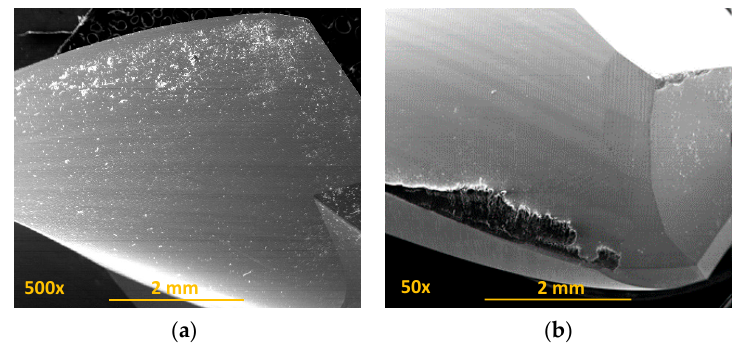
Figure 7. Accumulation of carbon fibre adhered to the tool: ( a ) face rake; ( b ) the area next to the guide surface of the tool.